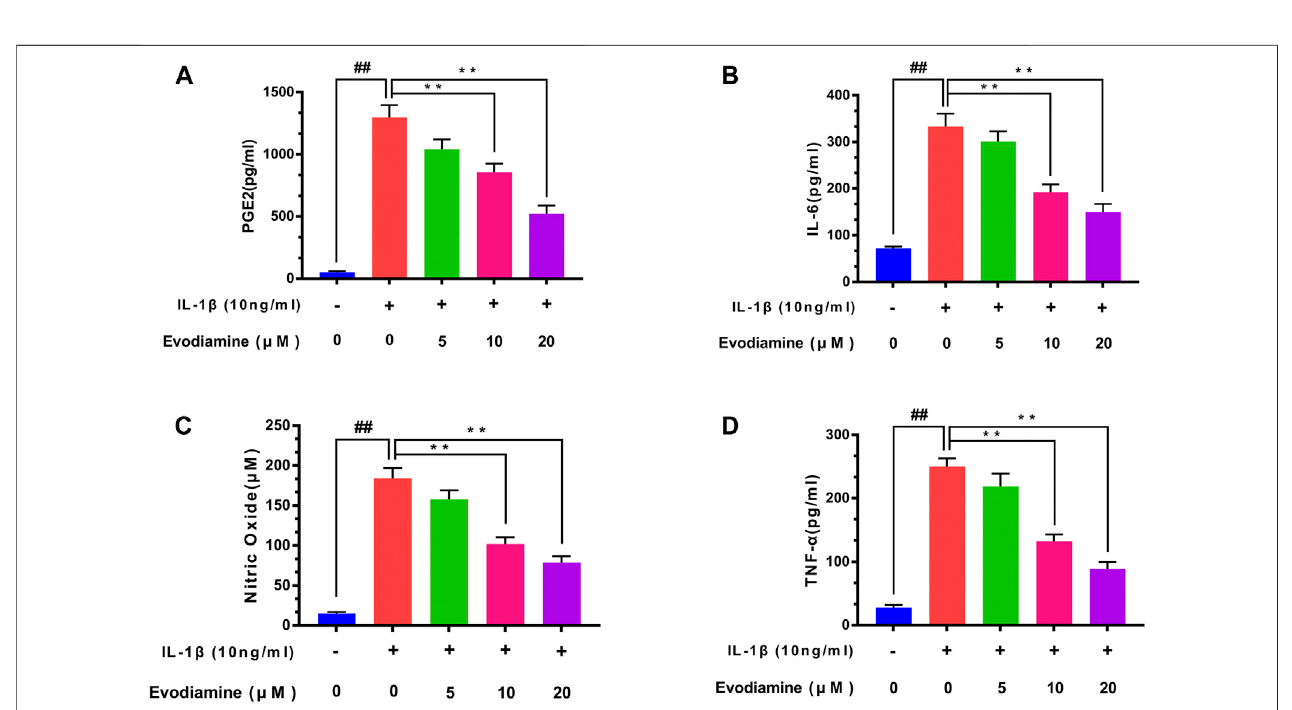
FIGURE 2 | Evodiamine suppressed the production of the in fl ammatory factors induced by IL-1 β . (A,B,D) Expression of PGE2, TNF- α , and IL-6 was detected by ELISA. (C) Nitricoxide(NO) concentrationswereassessed byGriessreaction.Thedatawereexpressed asmean±SD. Signi fi cantdifferences betweendifferentgroups are indicated as ## p < 0.01, vs. control group; pp p < 0.01, vs. IL-1 β alone stimulation group, n = 3.